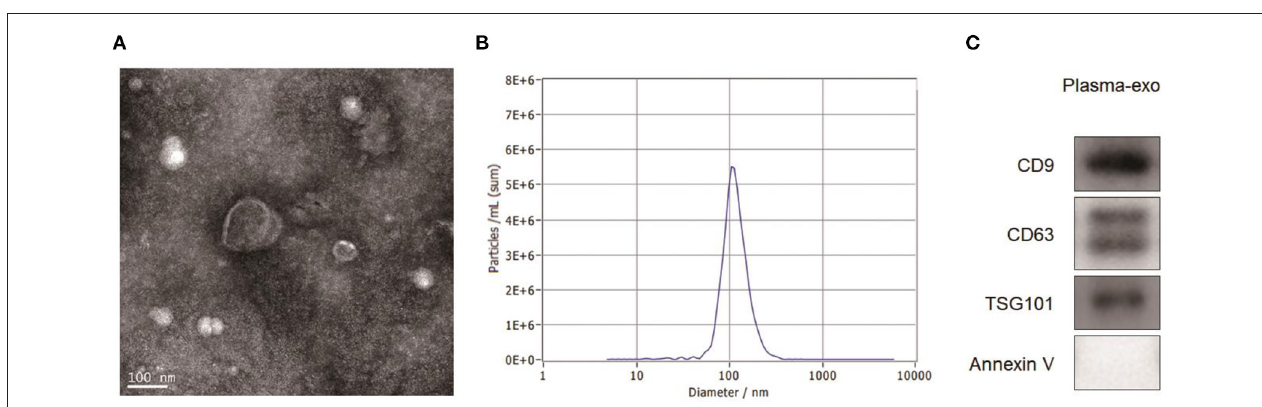
FIGURE 1 | Exosome characterization. (A) TEM images showed that aggregates of exosomes were distributed while connected. The exosomes had a diameter of 100–200nm and were shaped like a double disk-like vesicular structure that was completely covered with a lipid envelope. (B) The results of exosome particle size detected by NTA showed that the median value of the overall particle size was approximately 100nm, and particle size was mainly distributed between 50 and 200nm. (C) Western blotting showed the positive expression of the exosome marker proteins Annexin V, CD9, Tsg101, and CD63 in the exosome group.